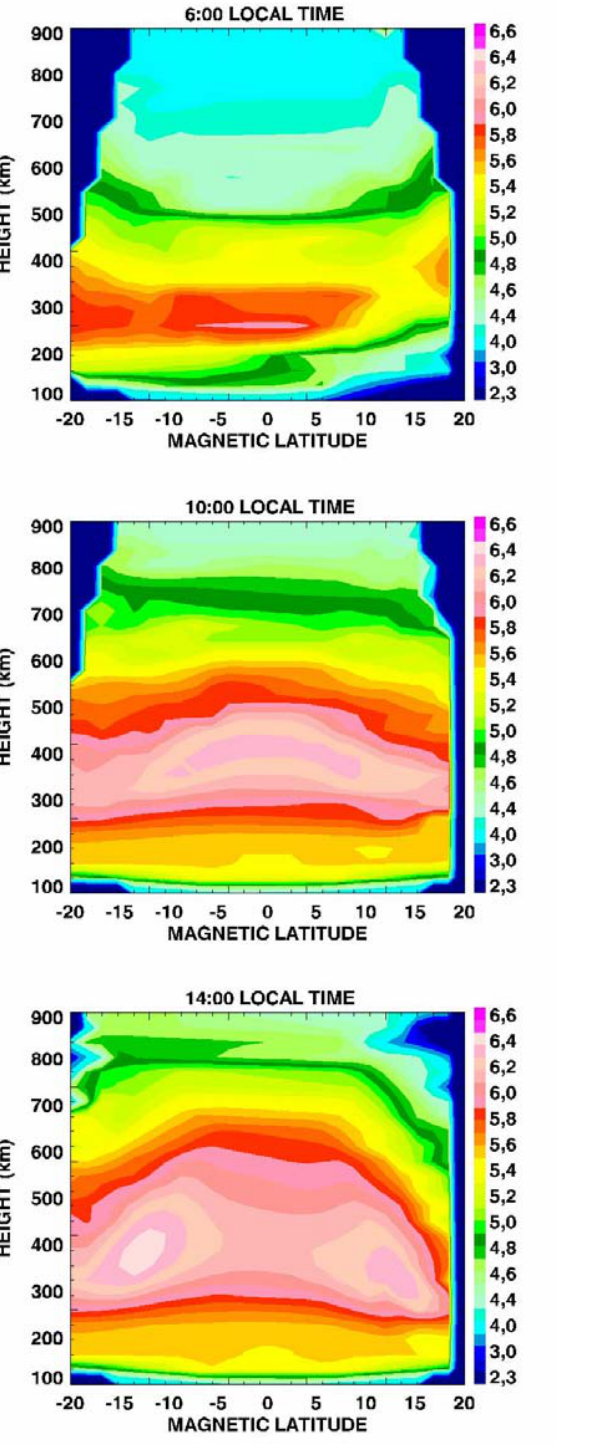
Fig. 2. Ionospheric electron density distribution as a function of height and magnetic latitude for various local times generated by the LION model for average solar conditions in the Brazilian longitudinal region, during summer in the Southern